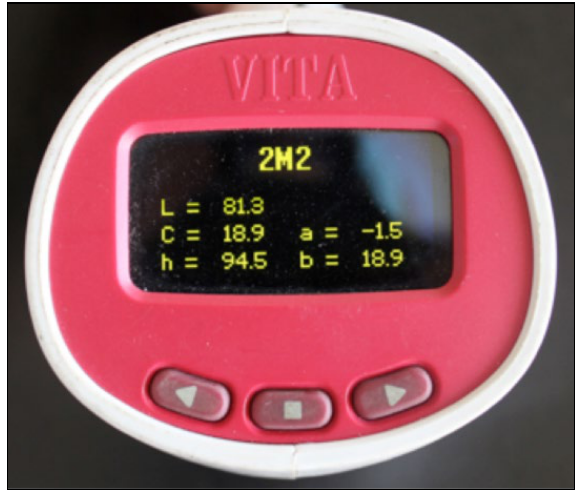
Figure 1. Measurement of CIE L*, a*and b* parameters using Vita Easyshade Compact